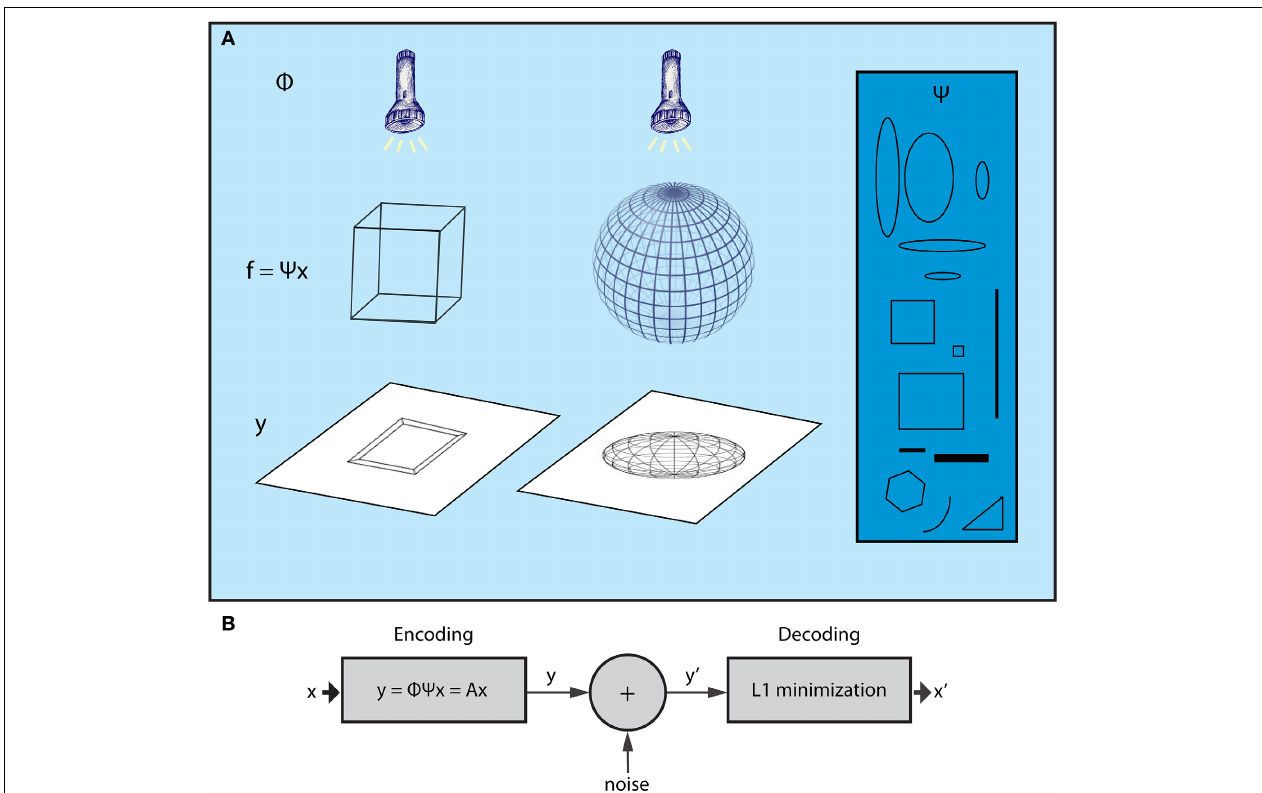
FIGURE 1 | The Compressed Sensing framework. (A) The essence of the CS framework can be conceived if we consider the example of the wire-frame object (Ganguli and Sompolinsky, 2012). The three-dimensional object (e.g., a wire-frame cube or a wire frame sphere) is projected onto a two dimensional screen when a light beam is applied on it. The wired frame represents the f signal, the light beams the sampling process ( (cid:2) ) whereas different shadows correspond to different samples of the signal (vector y ). CS shows that it is possible to reconstruct the initial wire frame (e.g., the cube or the sphere) from a set of different shadows, as long as the wire frame is sparse enough and the sampling is random. For instance, consider a non-random lighting where the light beams are aligned with a specific wire of the object. The shadows would be biased to that wire and, as a result, not